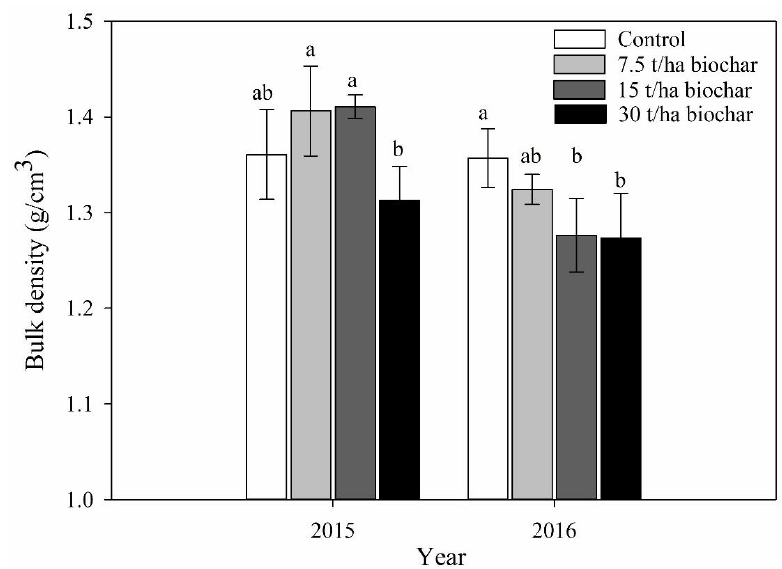
Figure 2. Bulk density (BD) as affected by biochar (BC) treatment. Error bars respresent one standard deviation from the mean. Different letters indicate significant difference ( p < 0.05) between control and treatments in different